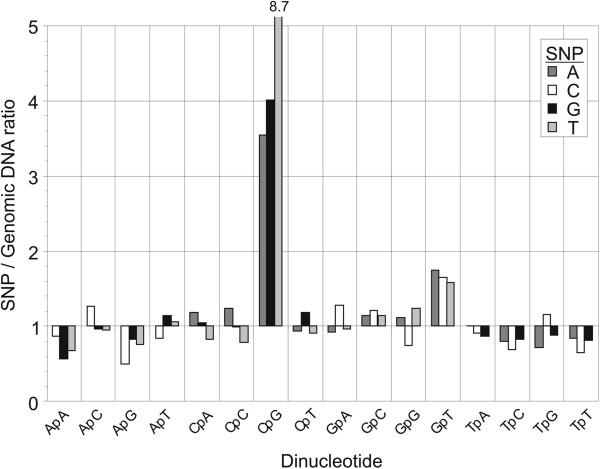
Frequencies of SNPs (y-axis) occurring in each dinucleotide context (x-axis) compiled from approximately 45 million SNPs in human genomic DNA sequences. These were categorised by mutation type and by the base downstream of the SNP (3′ dinucleotide context). Frequencies of SNPs were normalised to those predicted from dinucleotide frequencies and transition and transversion rates measured in the whole SNP dataset.